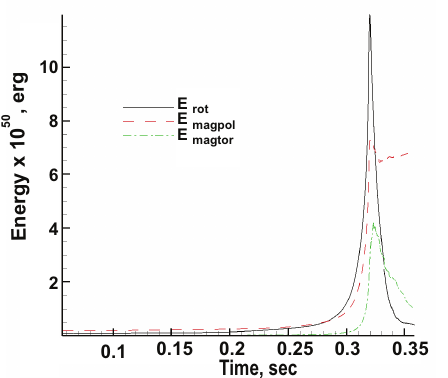
Figure 13: Time evolution of rotational energy E rot (solid line), magnetic poloidal energy E magpol (dashed line) and magnetic toroidal energy E magtor (dash- dotted line) for the case H 0 = 10 12 G , E rot 0 /E grav 0 =